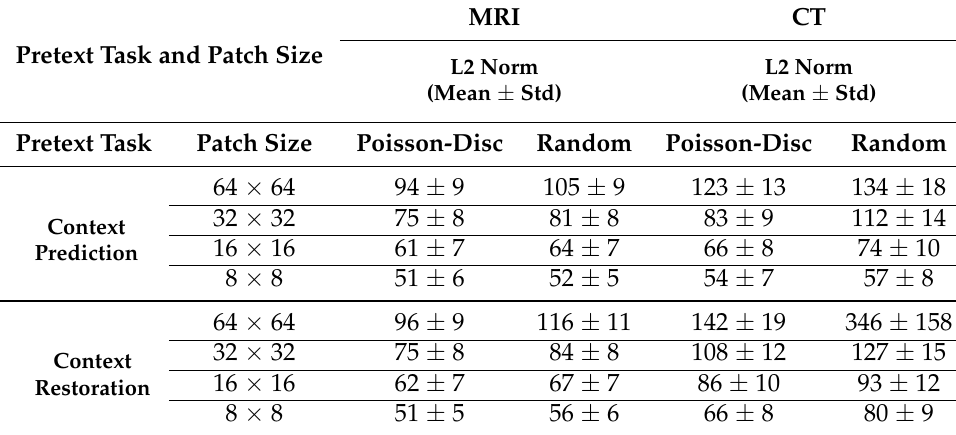
Figure 4. The downstream segmentation performance on the CT dataset for the Context Restoration pretext task as measured by the Dice score for every combination of patch size and sampling method used during pretraining, evaluated in five different scenarios of training data availability. In each scenario, every model is trained for segmentation using one of the five different subsets of training data as described in Section 2.1.2. The black dotted line in each plot indicates the performance of a fully-supervised model trained using all available training images. The light blue curve indicates the performance of a fully-supervised model when trained using each of the five different subsets of training data. Similar plots for the Context Prediction pretext task are given in Appendix C. Table 2. Quantitative evaluation of inpainting for every combination of pretext task, patch size, and sampling method. All values are rounded to the nearest